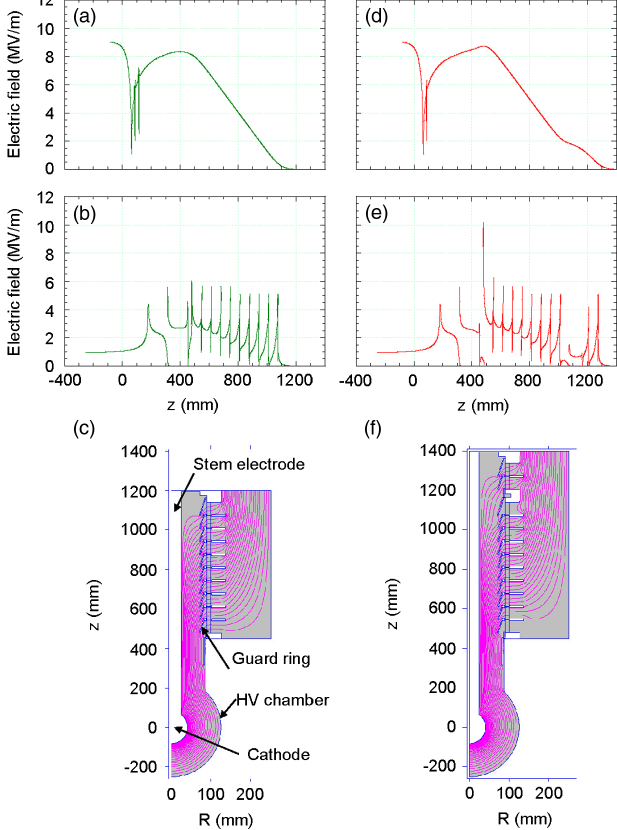
FIG. 8. Field distributions of the inner stem electrode, outer guard rings, and HV chamber for the original ten-segment insulator (left side) and the eight- plus two-segment insulator (right side). (a) and (d) Surface electric fields of the inner stem electrode at 500 kVas a function of z . (b) and (e) Surface electric fields of the outer anode chamber and guard rings at 500 kV as a function of z . (c) and (f) Field distributions inside the gun